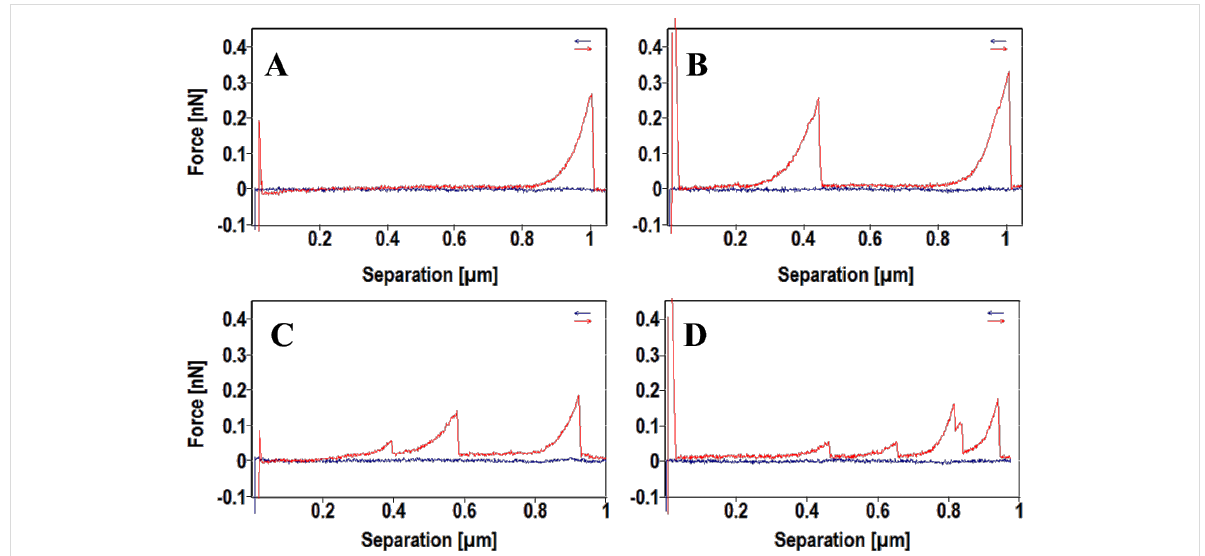
Figure 2: Typical force curves with different number of rupture events. A) Single event. B) Double events. C) Triple events. D) Multiple events.